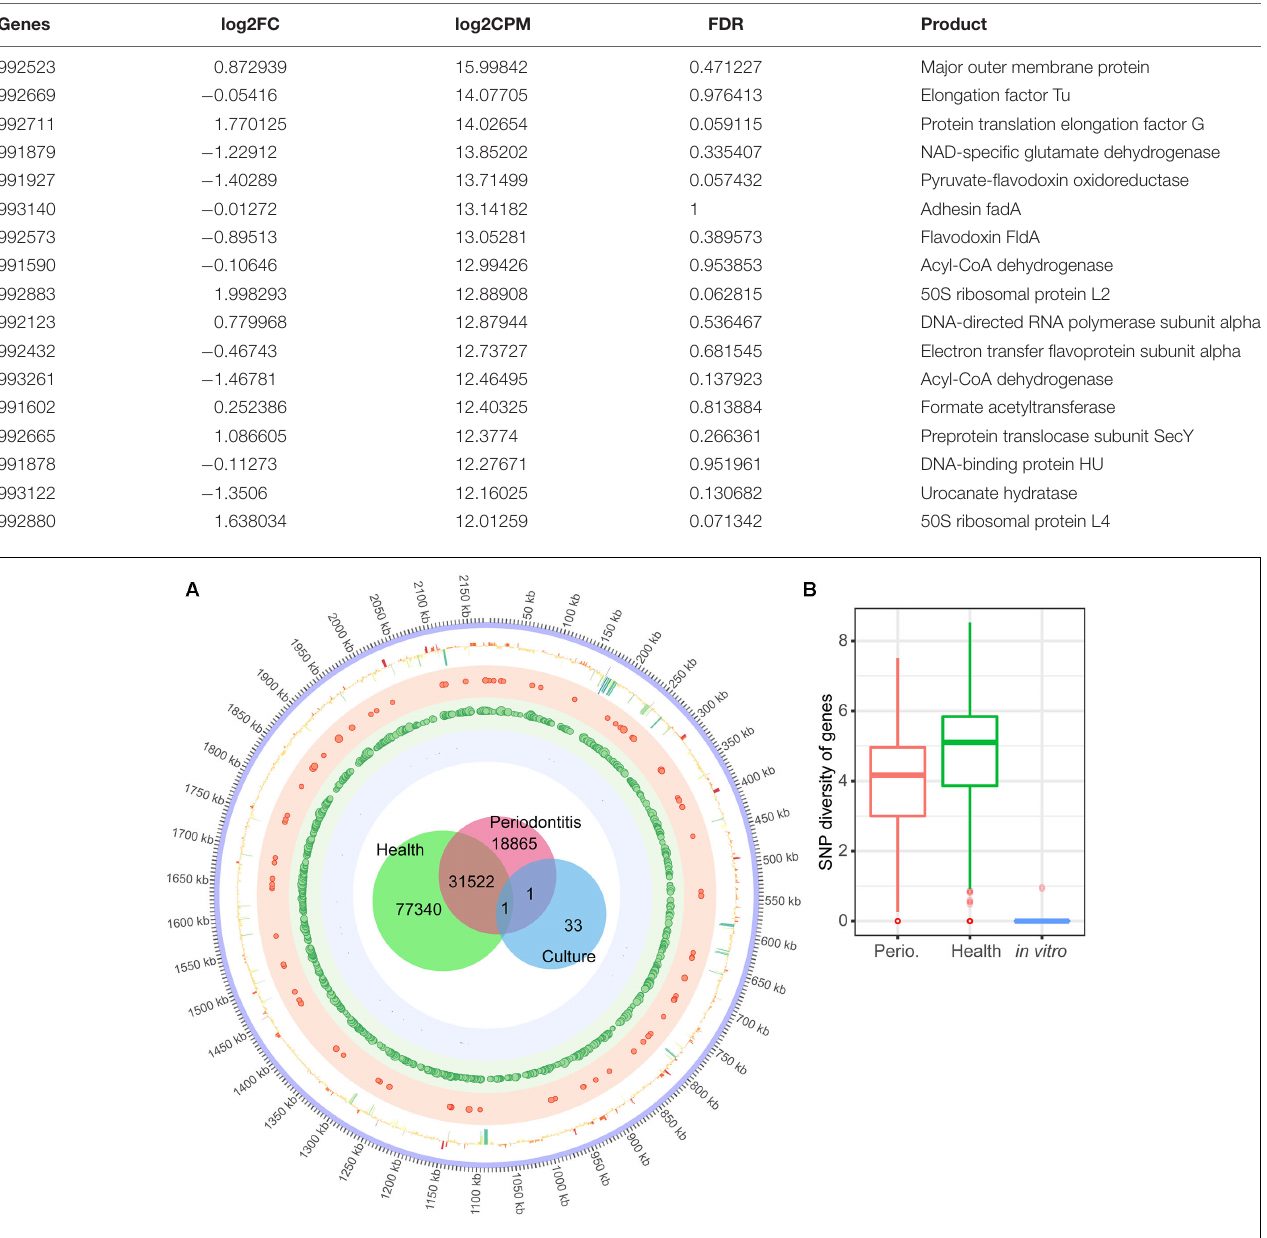
TABLE 6 | Highly expressed genes (log2CPM ≥ 12) in both periodontitis and laboratory culture in F. nucleatum. Genes log2FC log2CPM FDR